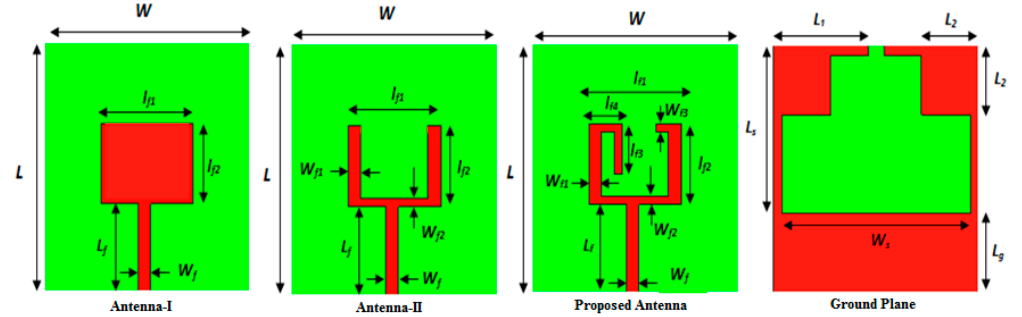
Figure 1. Optimization process of anticipated antenna .